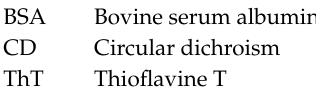
Figure S1: CD data of BSA without the existence of C-phycocyanin; Figure S2: CD data of BSA with the existence of C-phycocyanin.; Figure S3: Two models between BSA and monomer of C-phycocyanin with less interactions; Figure S4: One example model between BSA and trimer of C-phycocyanin; Figure S5: One example model between BSA and hexamer of